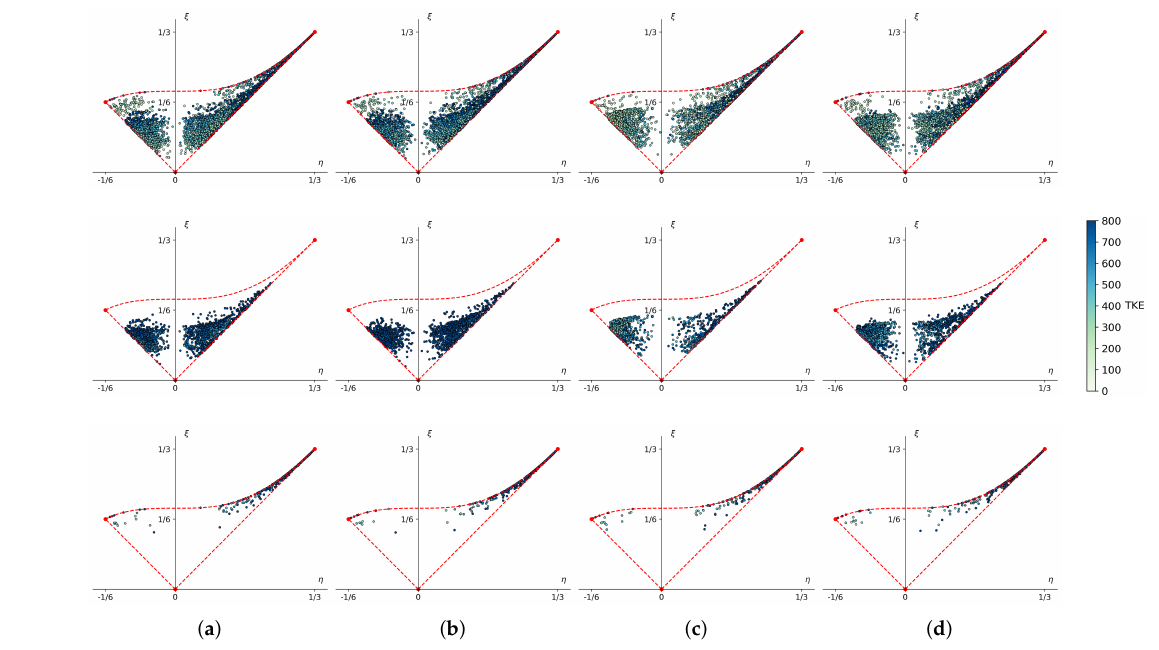
Figure 19. Turbulence triangle at plane 41. ( a ) F99. ( b ) F65. ( c ) T0. ( d ) T2.